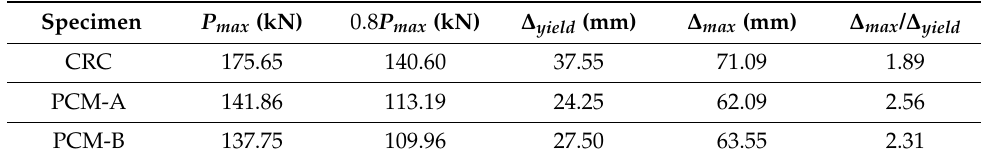
Figure 16. Displacement ductility. Table 4. Comparison of displacement